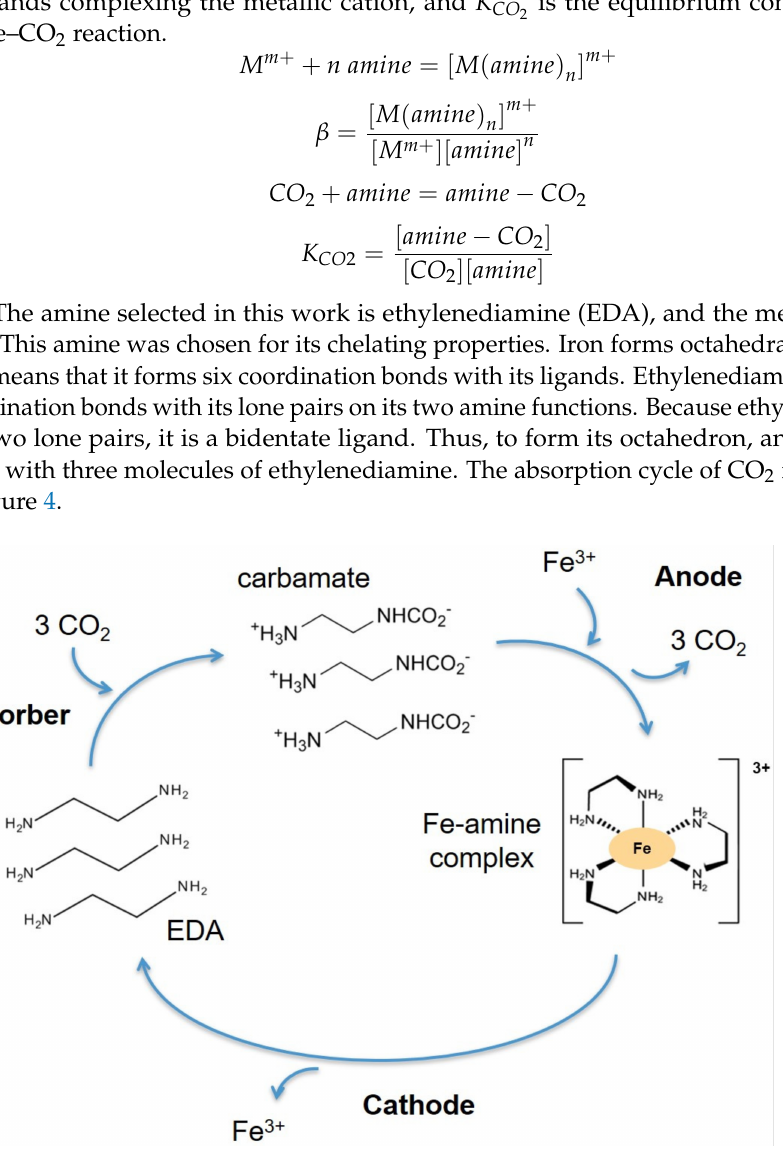
Figure 4. The absorption cycle of CO 2